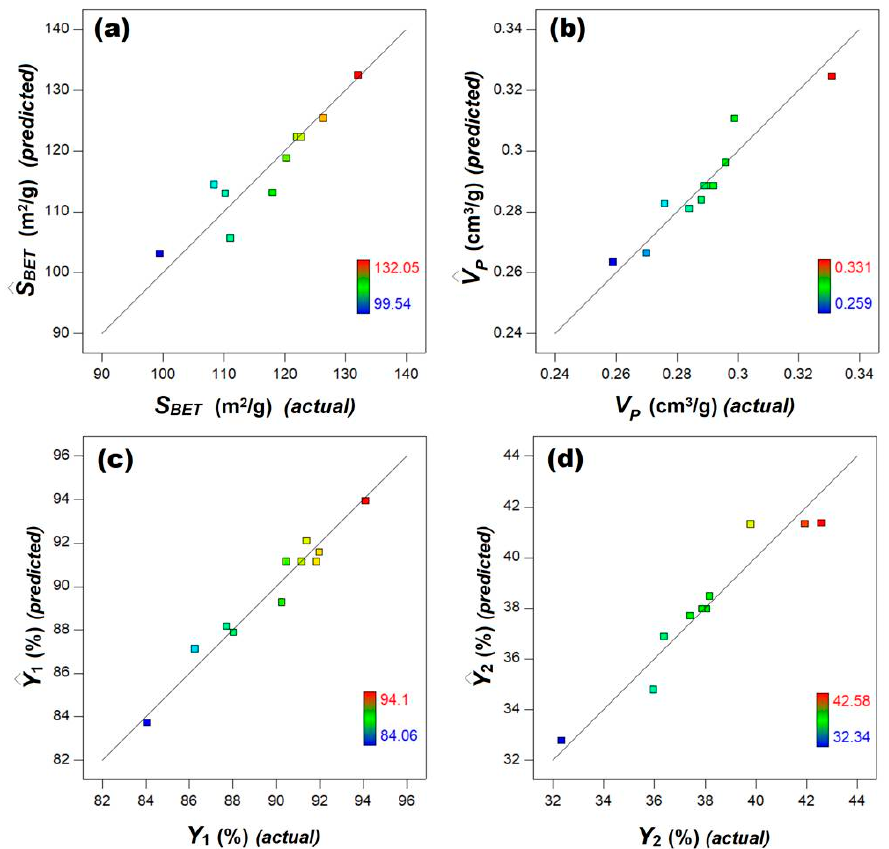
Figure 1. Parity plots showing the agreement between actual (observed) and predicted responses calculated according to fitted models; responses: ( a ) BET surface area; ( b ) volume of the pores; ( c ) removal e ffi ciency of CR dye; ( d ) removal e ffi ciency of 2,4 D pesticide.